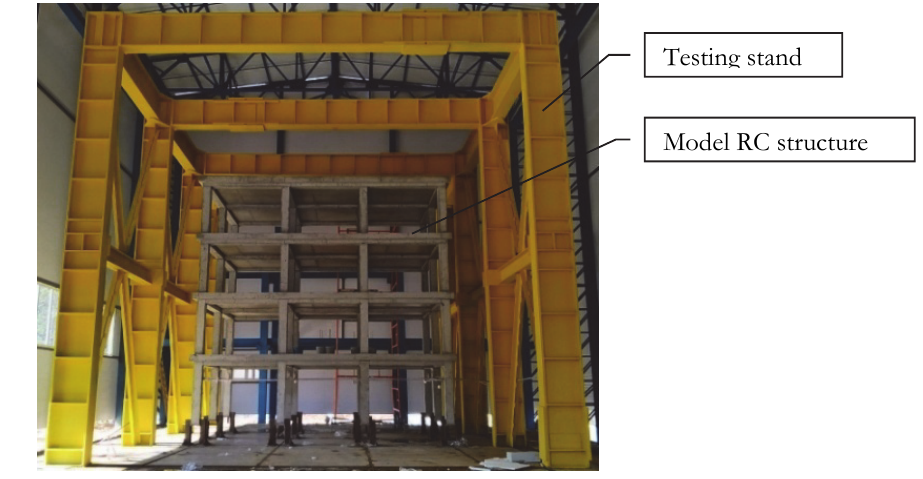
Figure 1: Testing stand with installed model RC